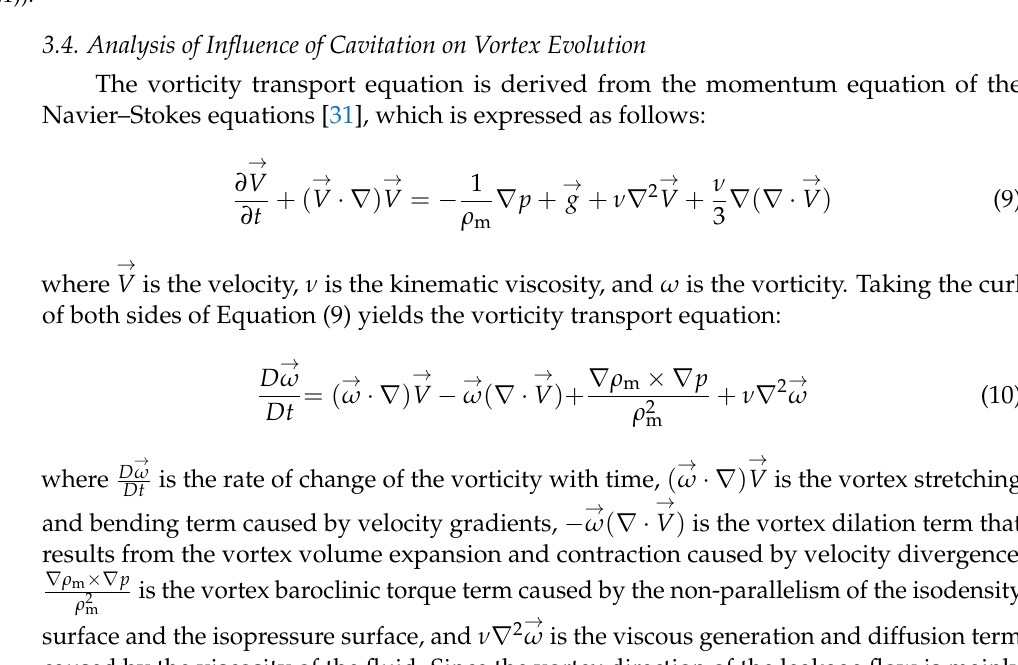
Figure 16. Comparison of the turbulent kinetic energy k distribution on the three planes for the cavitating case ( upper ) and non-cavitating case ( lower ) (the solid point is the vortex center, and the white line represents the isovalue of the vapor volume fraction ( α v =